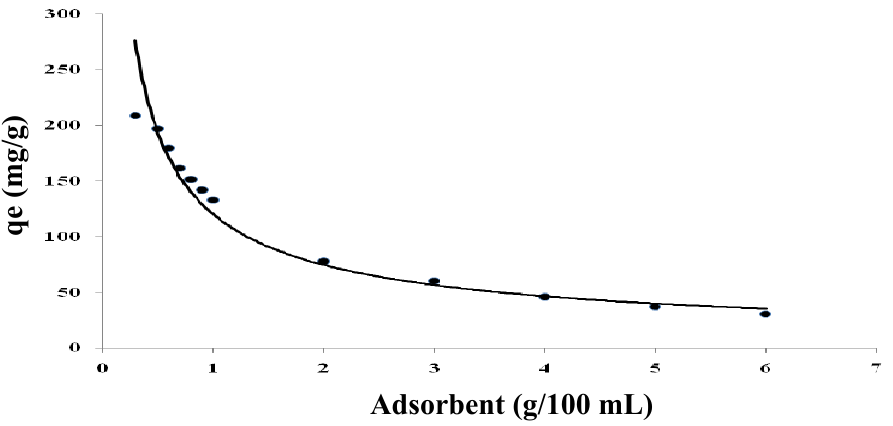
Figure 5. Effect of adsorbent concentration on cadmium(II) biosorption by modified Tamrix articulata wastes using 400 mg/L of cadmium at pH 4 and 30